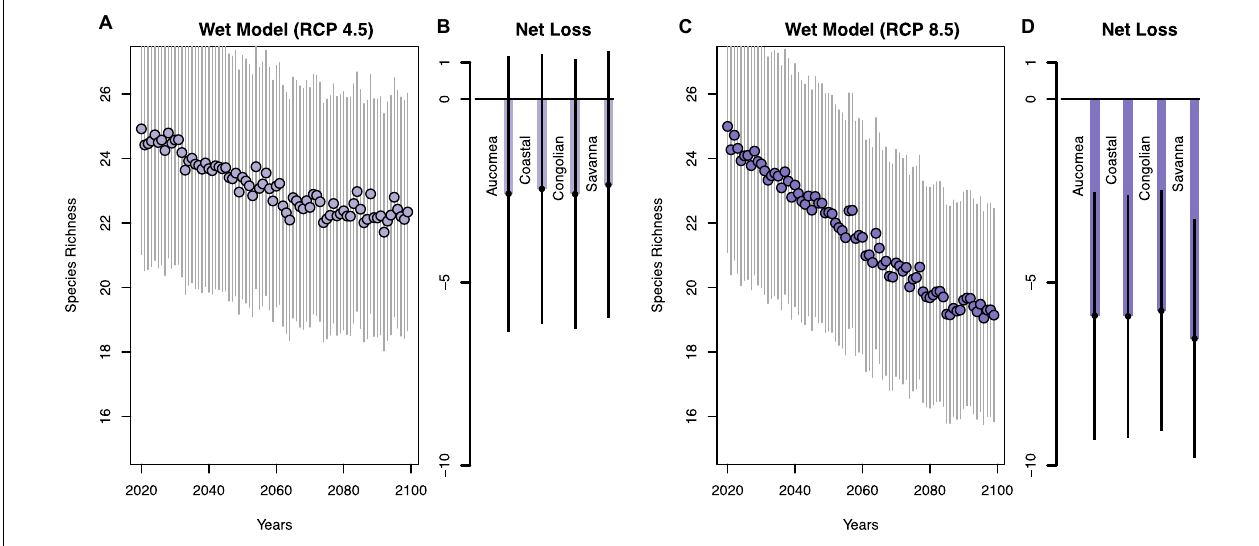
FIGURE 3 | Declines in estimated plot-level species richness and the estimated net tree species loss for each forest type by the end of the century for RCP 4.5 (A,B) and RCP 8.5 (C,D) for the wet model.